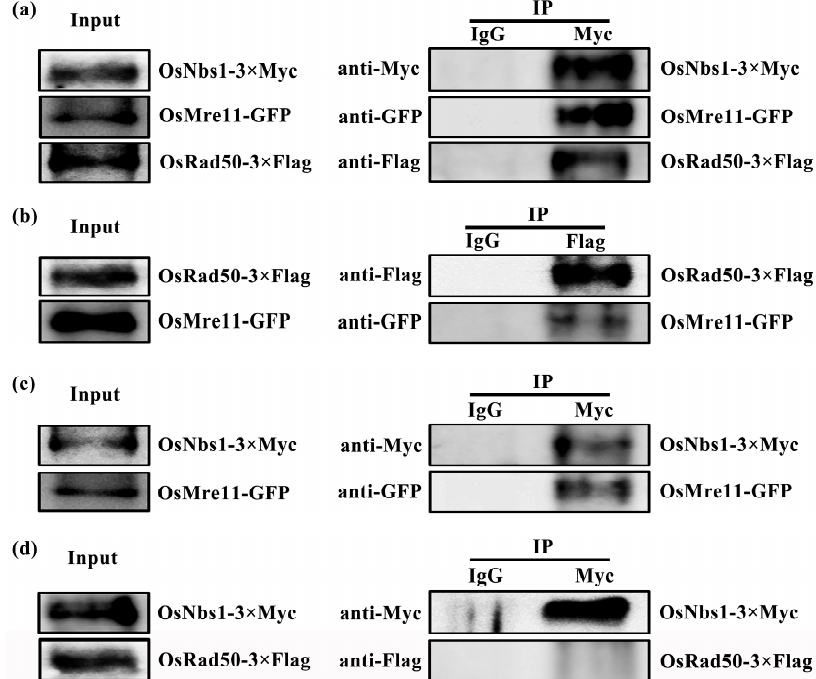
Figure 8. The interaction relationship between OsMre11, OsRad50, and OsNbs1 by coimmunoprecipitation (Co-IP) assay. ( a ) The 35S::OsNbs1-3 × Myc, 35S::OsMre11-GFP, and 35S::OsRad50-3 × Flag were immunoprecipitated using anti-Myc antibody, and analyzed using anti-Myc, anti-GFP, and anti-Flag antibodies. ( b ) The 35S::OsRad50-3 × Flag and 35S::OsMre11-GFP were immunoprecipitated using anti-Flag antibody, and analyzed using anti-Flag and anti-GFP antibodies. ( c ) The 35S::OsNbs1-3 × Myc and 35S::OsMre11-GFP were immunoprecipitated using anti-Myc antibody, and analyzed using anti-Myc and anti-GFP antibodies. ( d ) The 35S::OsNbs1-3 × Myc and 35S::OsRad50-3 × Flag were immunoprecipitated using anti-Myc antibody, and analyzed using anti-Myc and anti-Flag antibodies. ( a – d ) IgG was the negative control group.